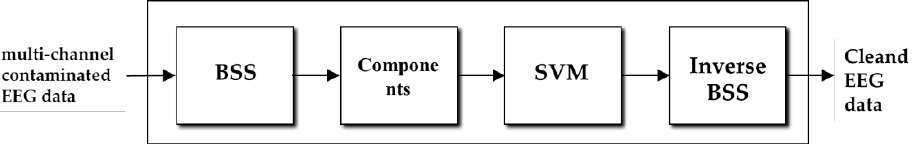
Figure 6. Process flow of BSS-SVM method.